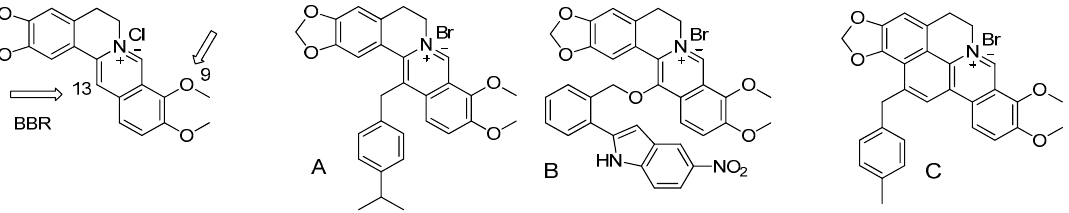
Figure 1. Chemical structure of reported antimicrobially active derivatives of berberine obtained by modification by phenyl ( A ), ether link ( B ) or cycloberberine ( C ) at position 13.